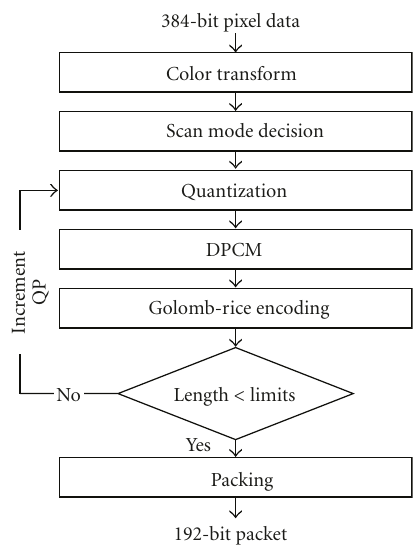
Figure 8: Flowchart of the FMC for the RGB color